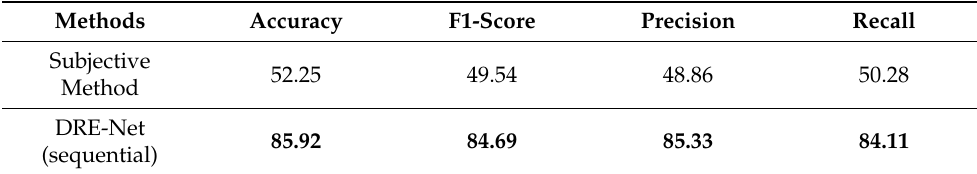
Table 10. Average performance comparison (10-folds) between subjective evaluation and the pro- posed DRE-Net (unit: %).